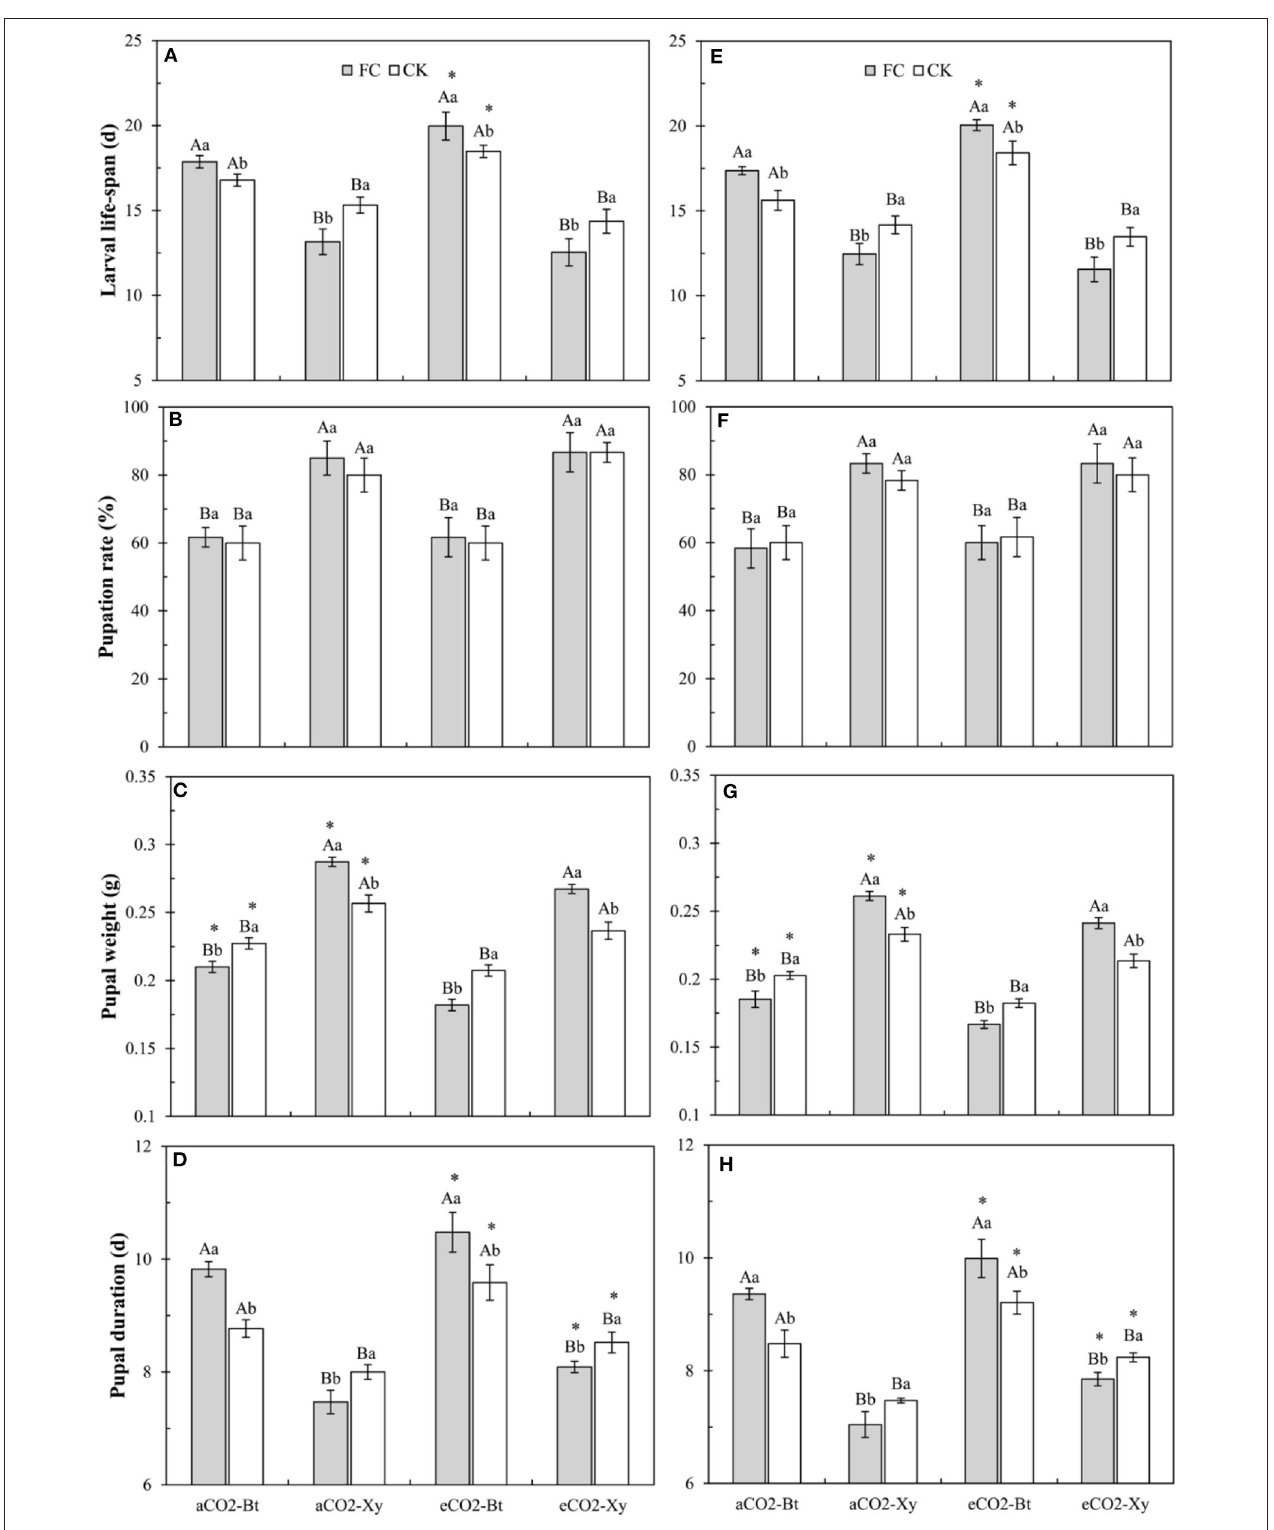
FIGURE 5 | Effects of the inoculation with arbuscular mycorrhizal fungi (AMF), F. caledonium, on the growth and development of M. separata larvae fed on Bt maize (Bt) and its parental line of non- Bt maize (Xy) under ambient CO 2 ( a CO 2 ) and elevated CO 2 ( e CO 2 ) at the heading stage (BBCH-59) in 2017 (A–D) and 2018 (E–H) . (Note: the same as Figure 3 ) ( P < 0.05; n =